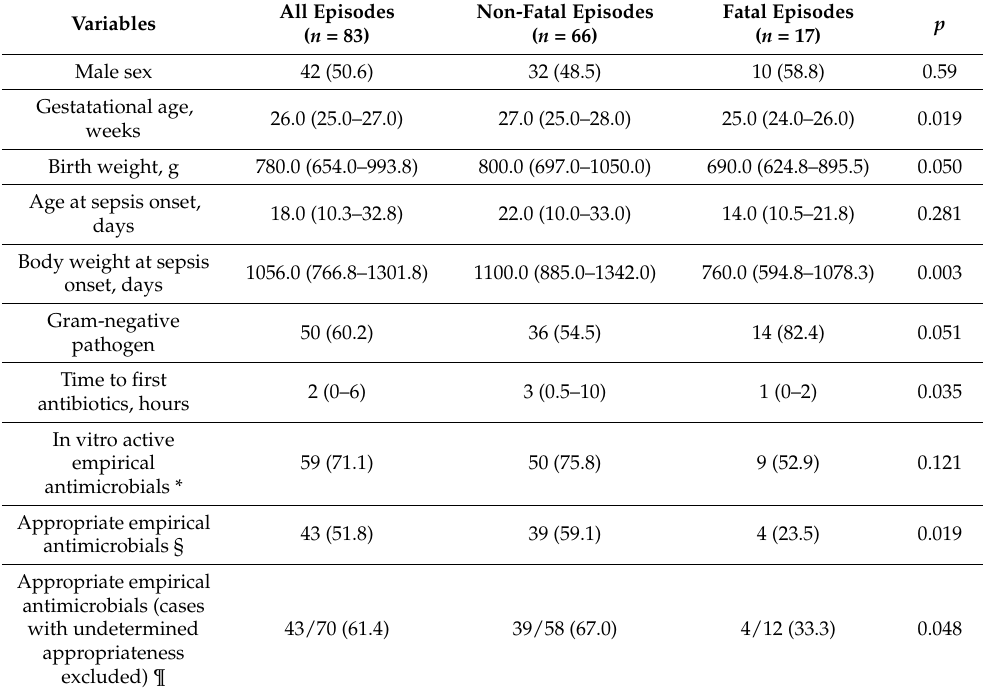
Table 1. Demographics of infants with late-onset sepsis episodes and characteristics of empiric antimicrobials. Categorical variables are reported as number and percentage. Continuous variables are reported as median and